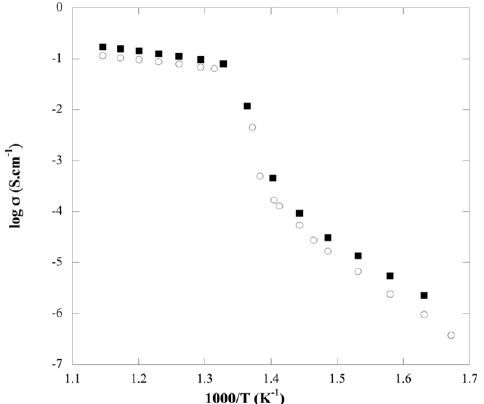
Figure 6. Arrhenius plot of the conductivity of BZY–LK30 composites under air ( ) and hydrogen ( ).